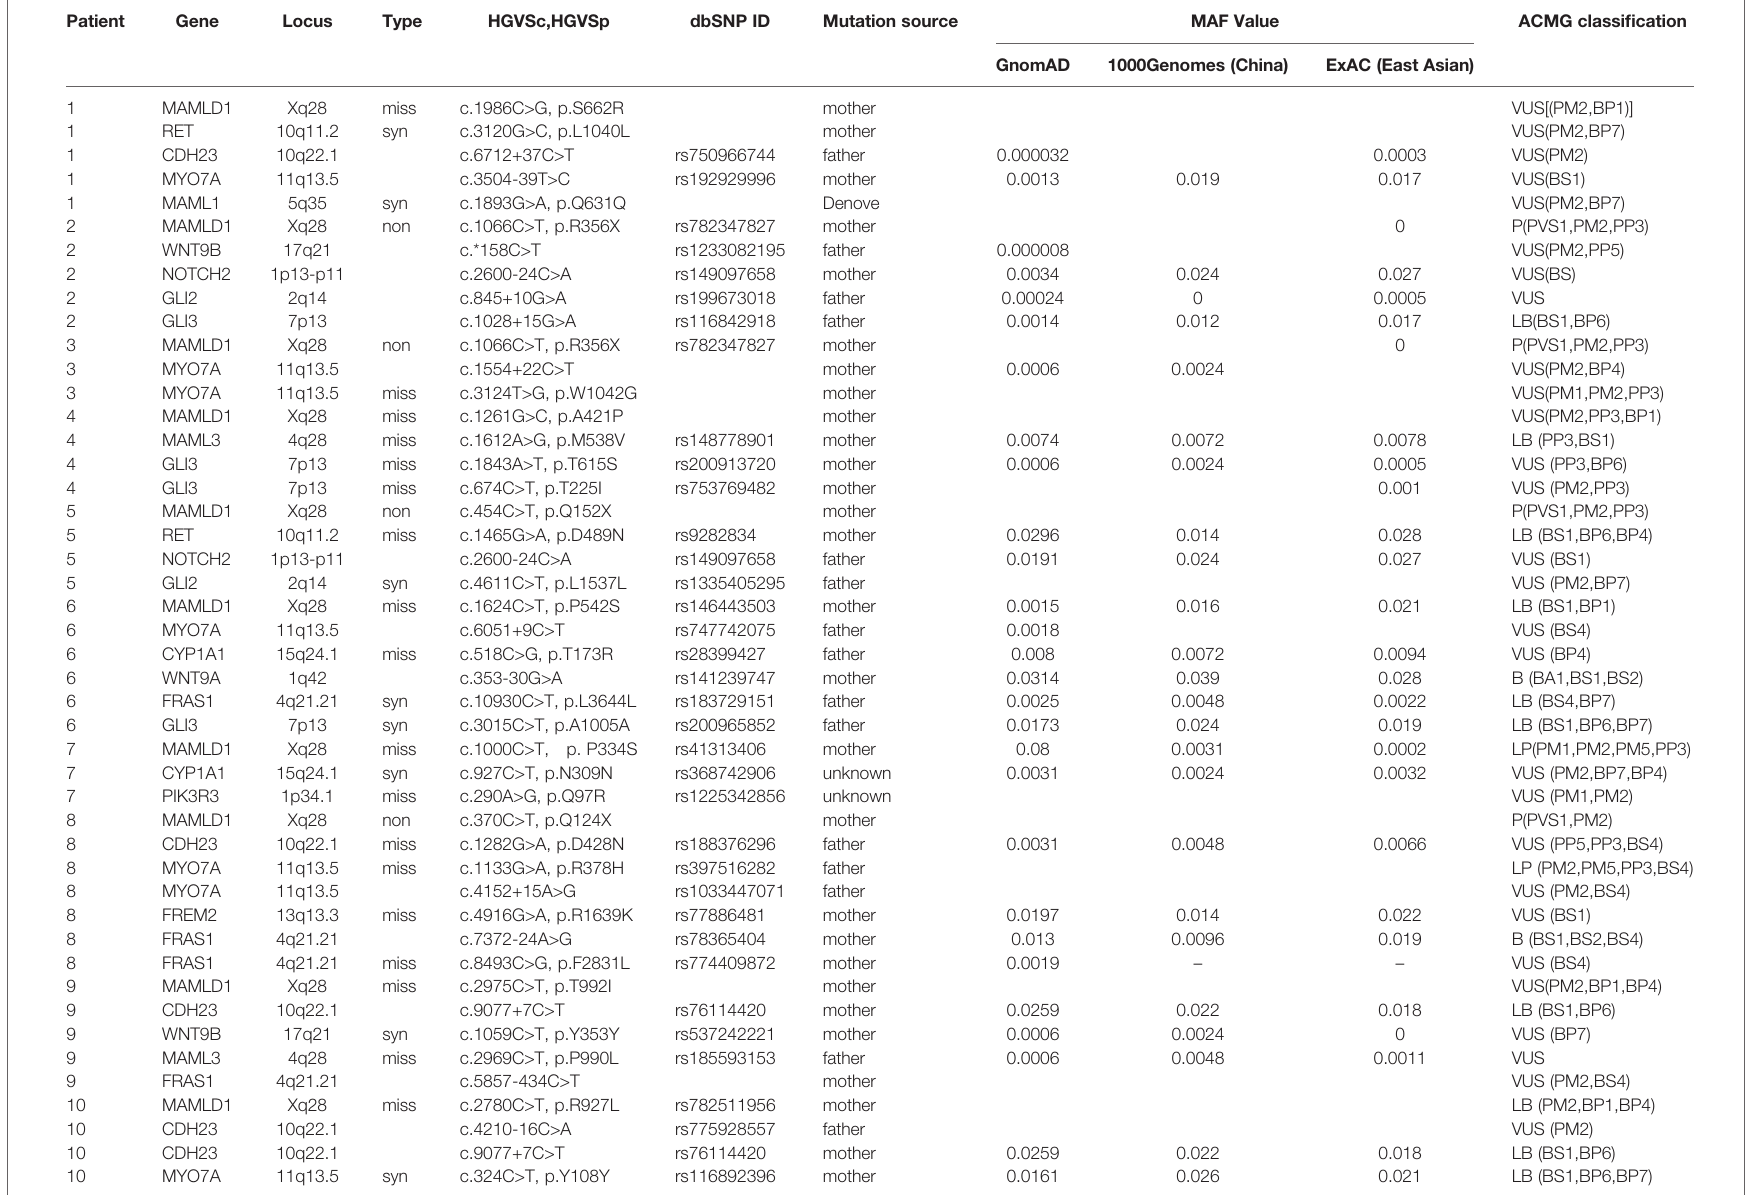
TABLE 1 | Identi fi ed genes and variants per patient after speci fi c fi